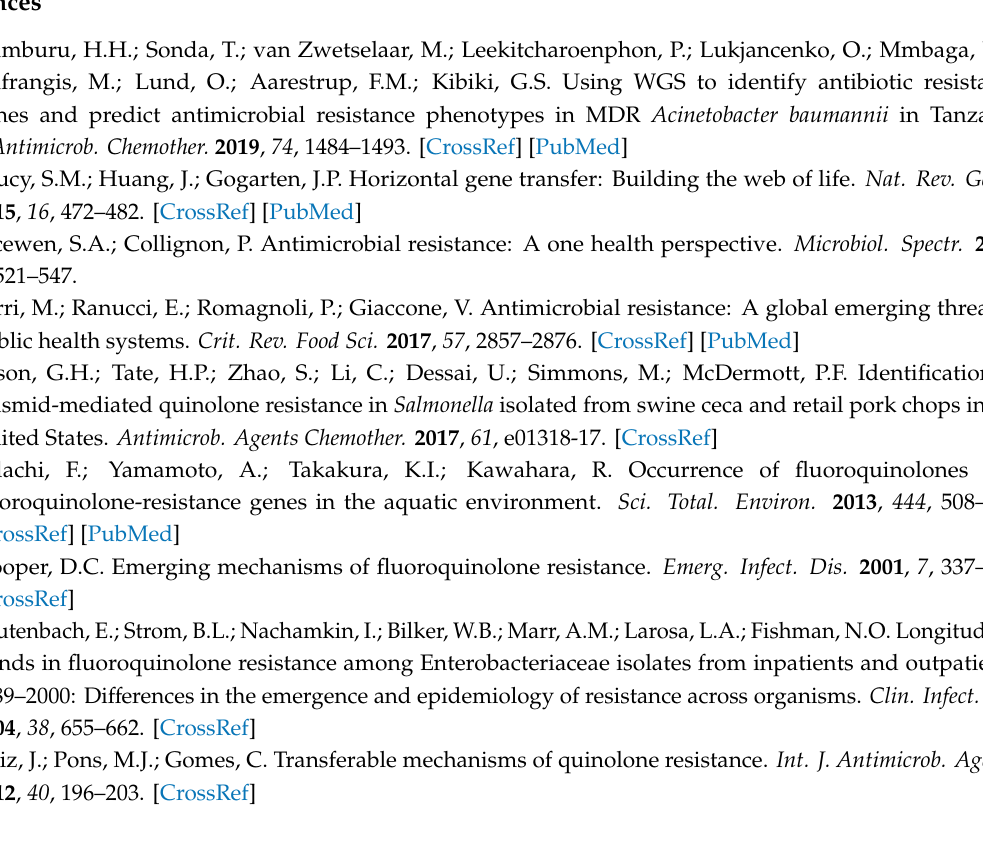
Table S1: Primers used in this study, Table S2: qnrD -carrying plasmids isolated from di ff erent